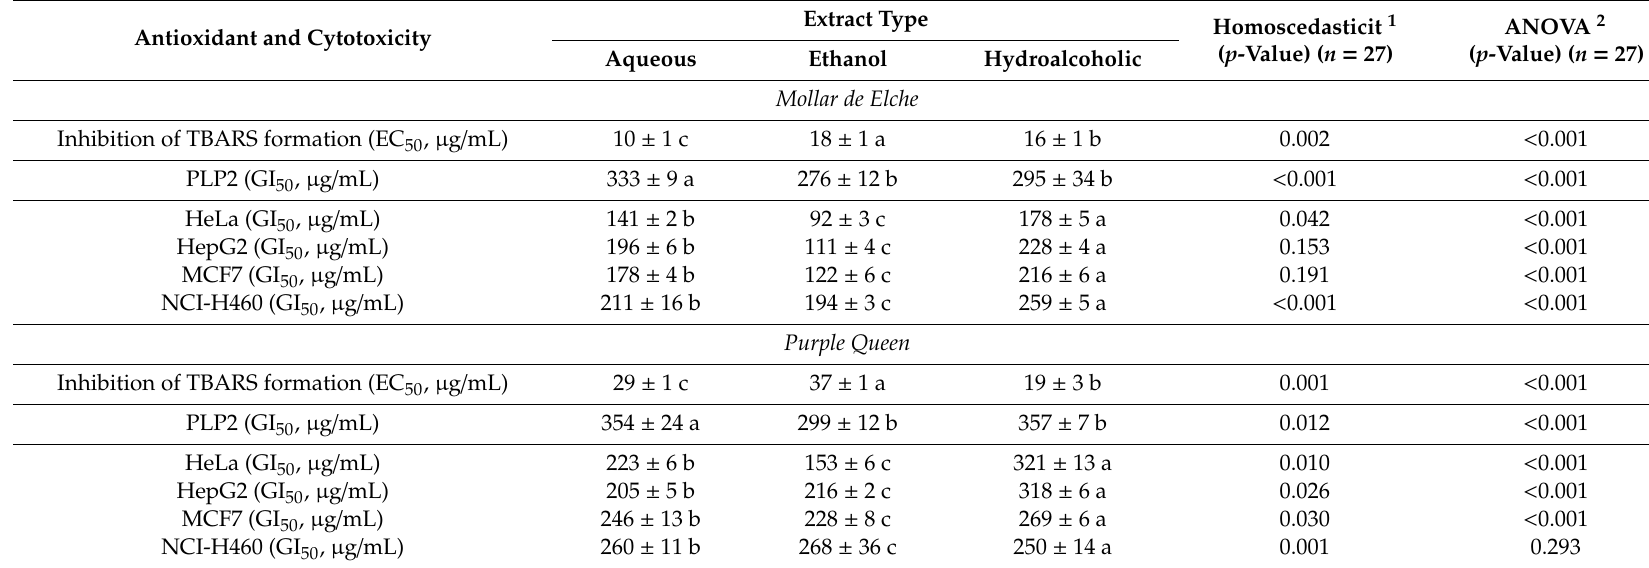
Table 3. Results of inhibition of the formation of thiobarbituric acid reactive substances (TBARS) and cytotoxicity in di ff erent extracts of the epicarp of the Mollar de Elche and Purple Queen